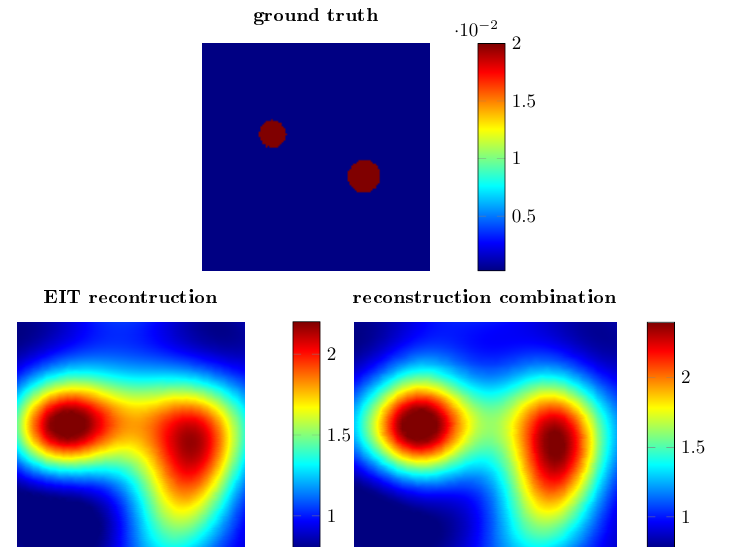
Figure 9. Top: Ground truth of the two conductivity enclosures. Bottom left: EIT reconstruction with no noise added and R 1 = 3. Note: There is no a priori information in the image. Bottom right: Combined reconstruction with a priori information with a truncation radius R 2 =